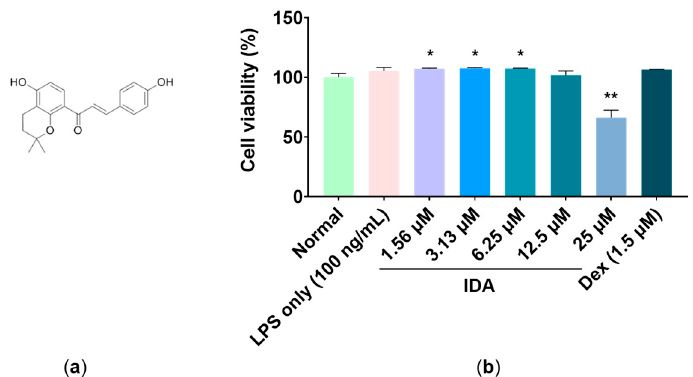
Figure 1. Effect of isodorsmanin A (IDA) on cell viability in RAW 264.7 macrophages: ( a ) The chemical structure of IDA. ( b ) Cells were pretreated with IDA (1.56, 3.13, 6.25, 12.5, or 25 µ M) for 3 h and then stimulated with 100 ng/mL lipopolysaccharide (LPS) for another 21 h. The experimental values are presented as the mean ± standard error of triplicate independent experiments. * p < 0.05 and ** p < 0.01 indicate significant differences vs. the non-treated control (Normal).